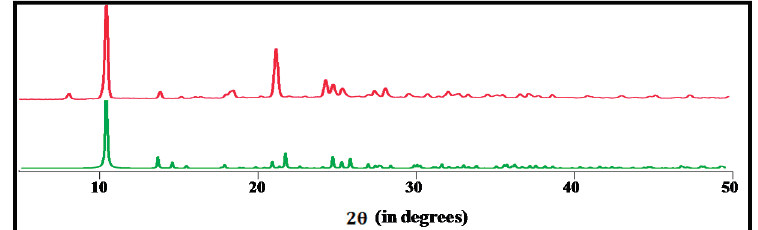
Figure 1. PXRD patterns of 1 , simulated (green) and bulk sample (red).